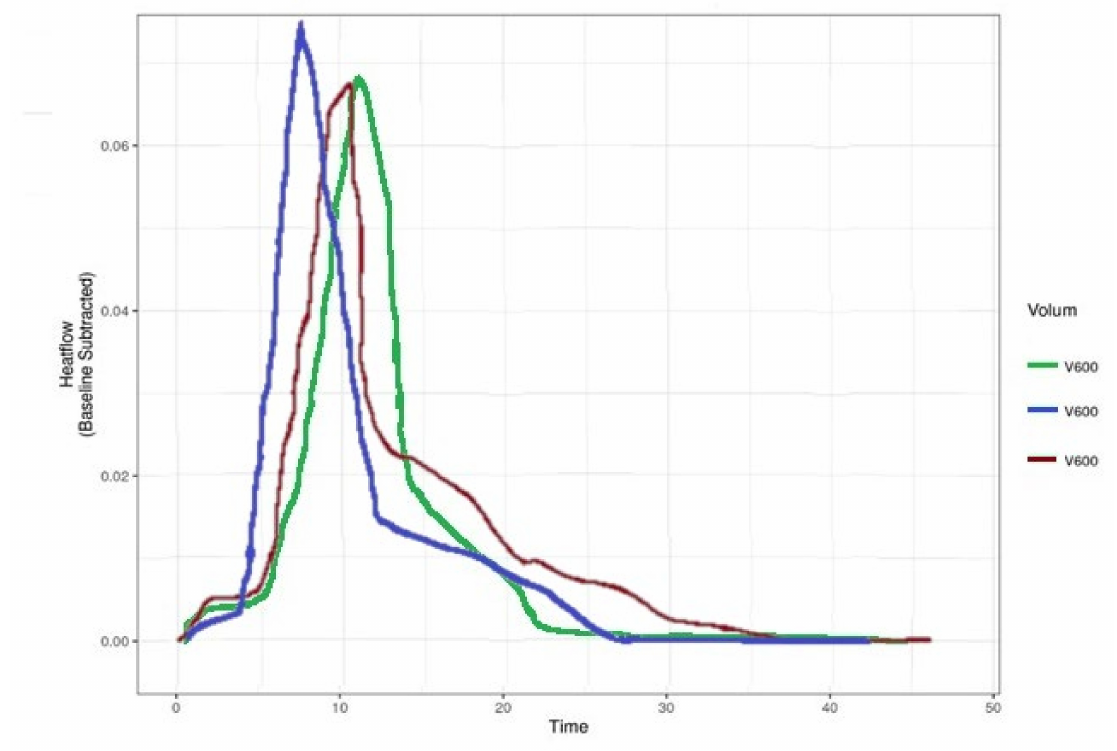
Figure 8. Graphical representation of the growth curves of the microorganisms studied and presented in Figures 5–7, grouped in the same graph—to facilitate the observation of differences in thermal